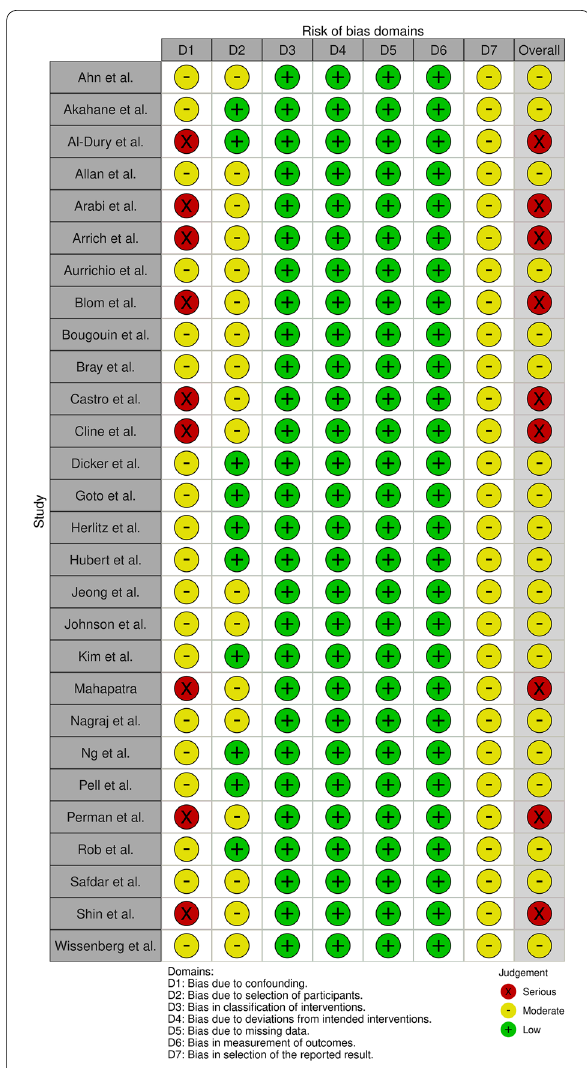
Fig. 2 Risk of bias visualisation for the primary outcome: adjusted survival to discharge (or 30-day survival) after